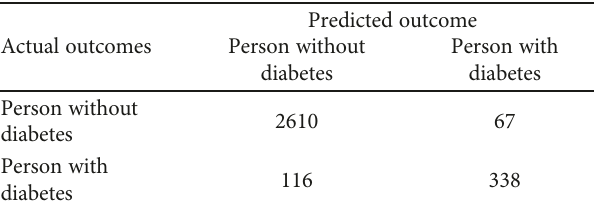
Table 2: The 19 rules extracted through the decision tree. Table 3: Confusion matrix of the test